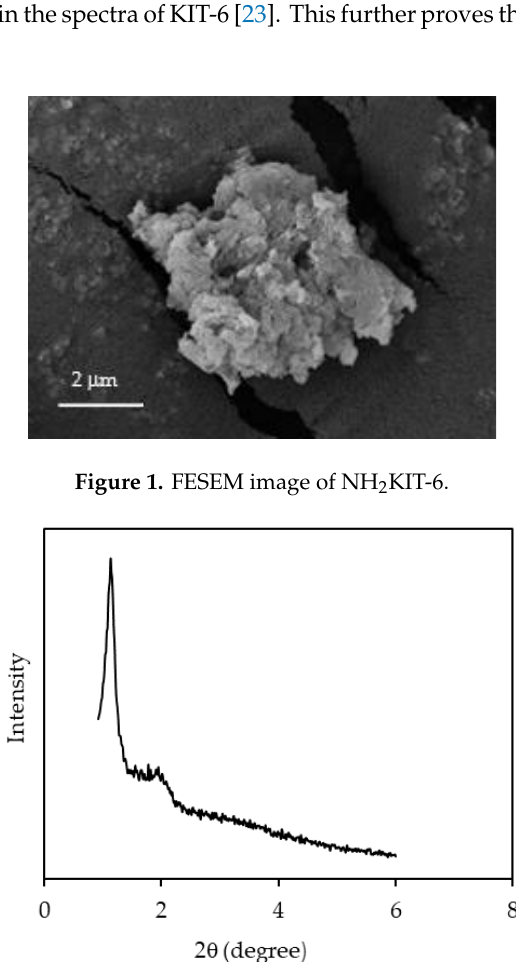
Figure 2. XRD pattern of NH 2 KIT-6.